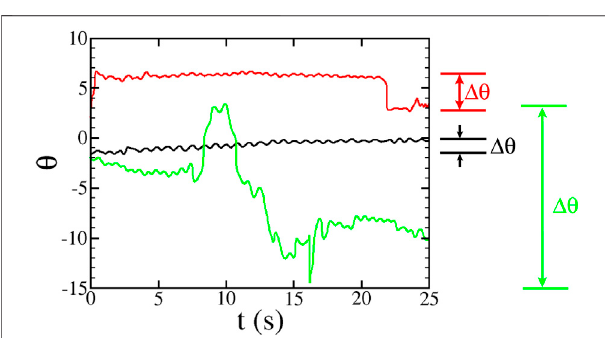
FIGURE 6 | : Sample plots of swimming orientation θ for three microbes inthehyperbolic fl owwith A =1.8s − 1 ( fl owrate0.100 ml/min). Δ θ isthelargest angulardifferencebetweenanytwopointsinthetrajectory.Theredandgreen trajectories have | Δ θ | > π and are labelled as “ tumblers ” whereas the blacktrajectorywith| Δ θ | < π islabelled a “ non-tumbler. ” Therocking motionof the swimming can be seen as oscillations in these